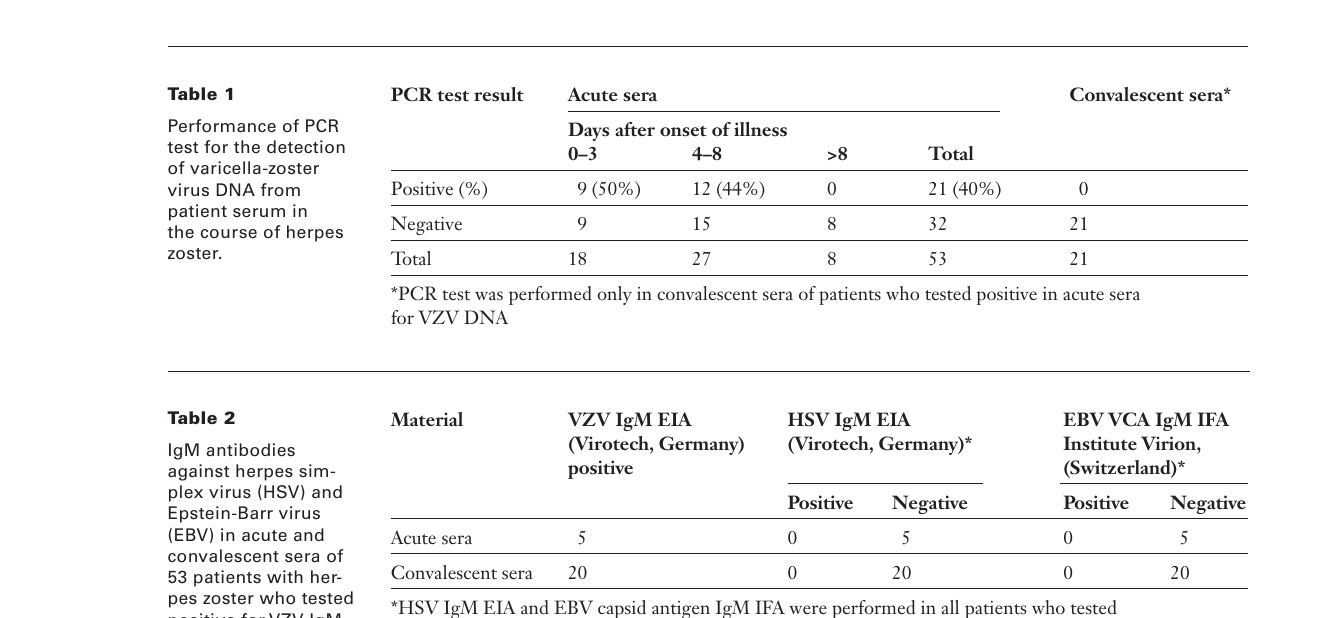
acute serum convalescent